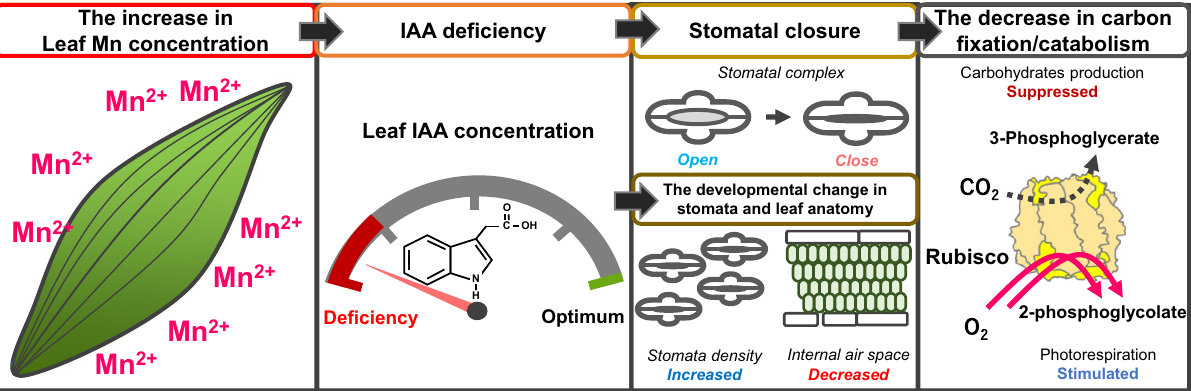
Figure 9. Visual scheme of symplastic Mn toxicity to suppress CO 2 assimilation. When Mn is excessively accumulated in leaves, the leaf IAA concentration is lowered, which might stimulate IAA degradation activities under Mn toxicity 57 . As a short-term effect, the decrease in IAA concentration affects stomatal opening 73 . Subsequently, as a long-term effect, the auxin-dependent signal transduction involving ARF transcriptional factor is perturbated in the leaves to cause an IAA-deficient phenotype, changing both the stomatal and leaf anatomical structures 71,72 . The change in stomatal function and leaf structure severely limits CO 2 diffusion to the chloroplasts, and CO 2 assimilation by Rubisco is inhibited. In contrast, the photorespiration reaction limits the photosynthetic electron activities to cause ROS production 82 . The decreased sugar production efficiency in photosynthesis suppresses sugar catabolism. Therefore, growth is inhibited under Mn-toxic